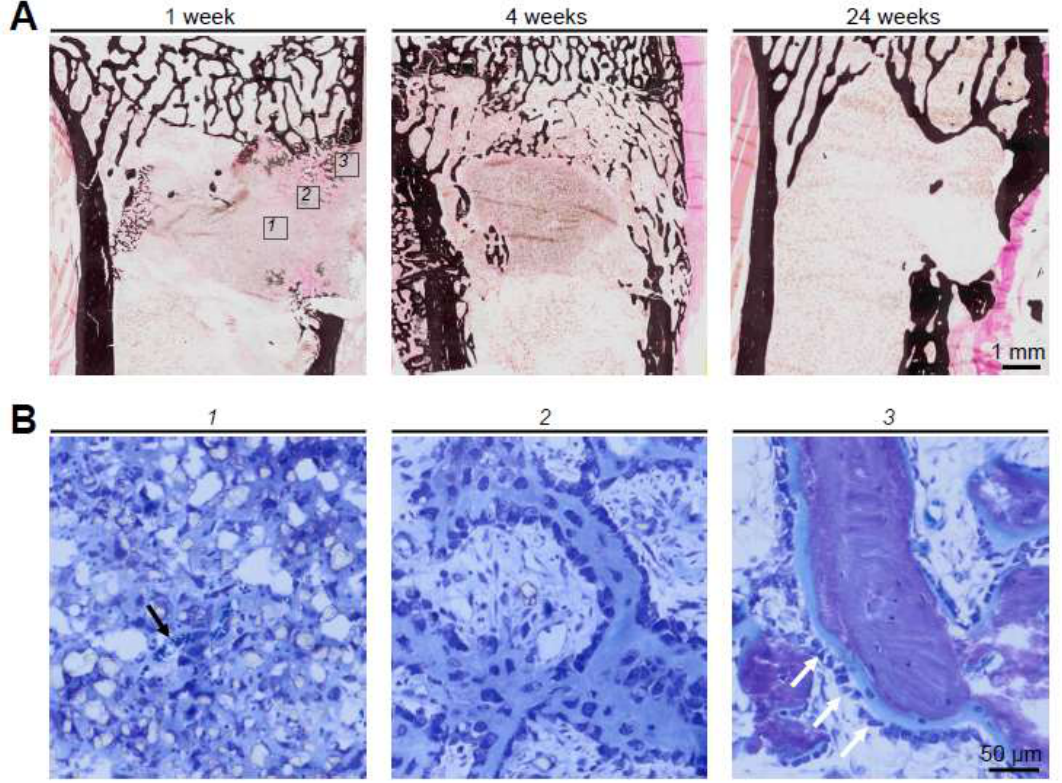
Figure 2. Remodeling of β -TCP (Cerasorb ® ) in rabbits [23]. ( A ) Von Kossa stained sections demonstrating the healing of the surgically induced tibial defect from the formation of intramedullary bone after 4 weeks to a new cortex until 24 weeks. Boxes 1-3 indicate the regions of interest that are shown at higher magnification below. ( B ) At higher magnification and in toluidine blue sections, the cellular process of the remodeling process can be reconstructed. (1): β -TCP granules and invasion by blood vessels (black arrow); (2) formation of immature, unmineralized bone; and (3) bone trabeculae and bone formation by osteoblasts (white arrows).